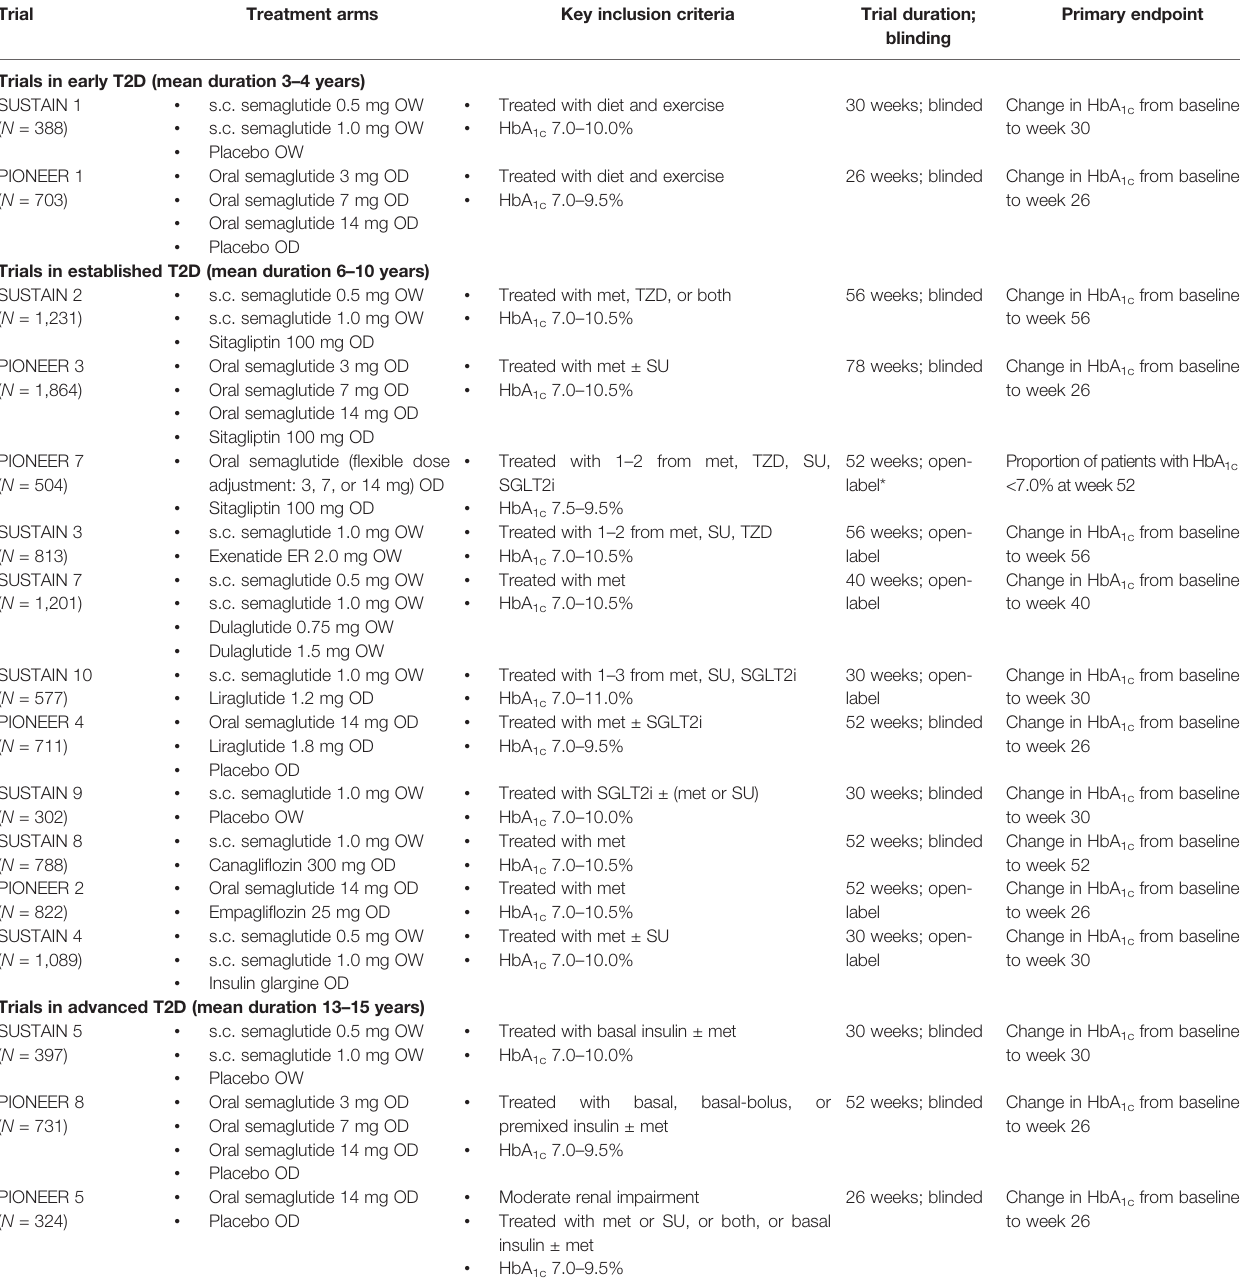
TABLE 1 | Summary of the designs of the global glycemic ef fi cacy SUSTAIN and PIONEER trials (16 – 26). Trial Treatment arms Key inclusion criteria Trial duration;